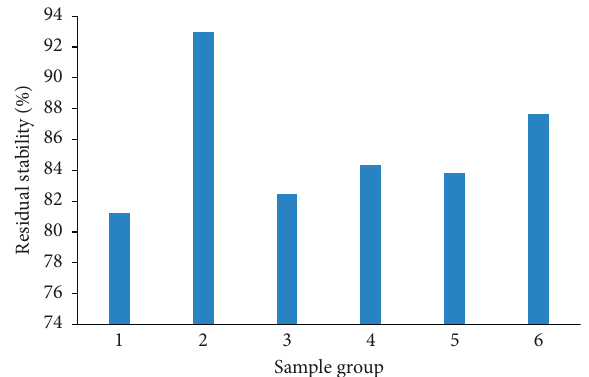
Figure 6: Column diagram of residual stability in each